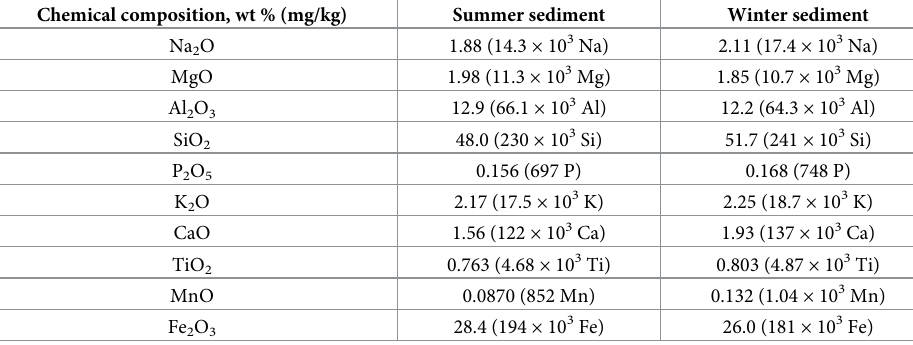
Values in the parentheses represent concentrations of selected elements in units of